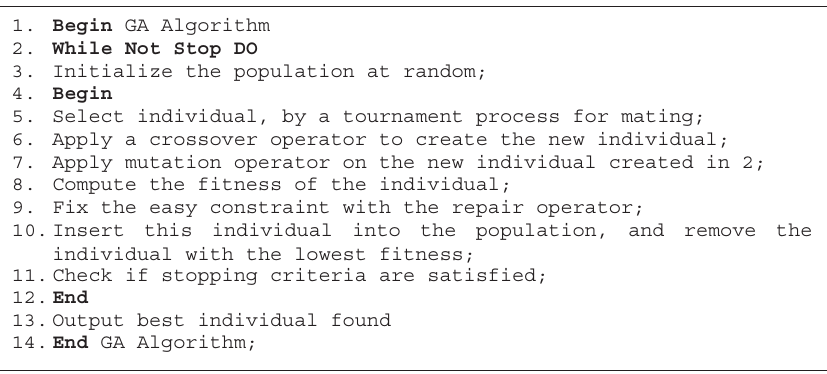
Figure 2: Pseudo-code of the Genetic Algorithm Scheduling